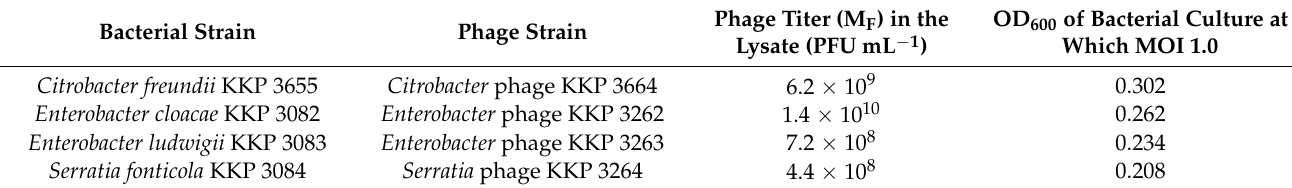
Table 2. The concentration of phages in lysates and optimal optical densities of bacterial cultures. Bacterial Strain Phage Strain